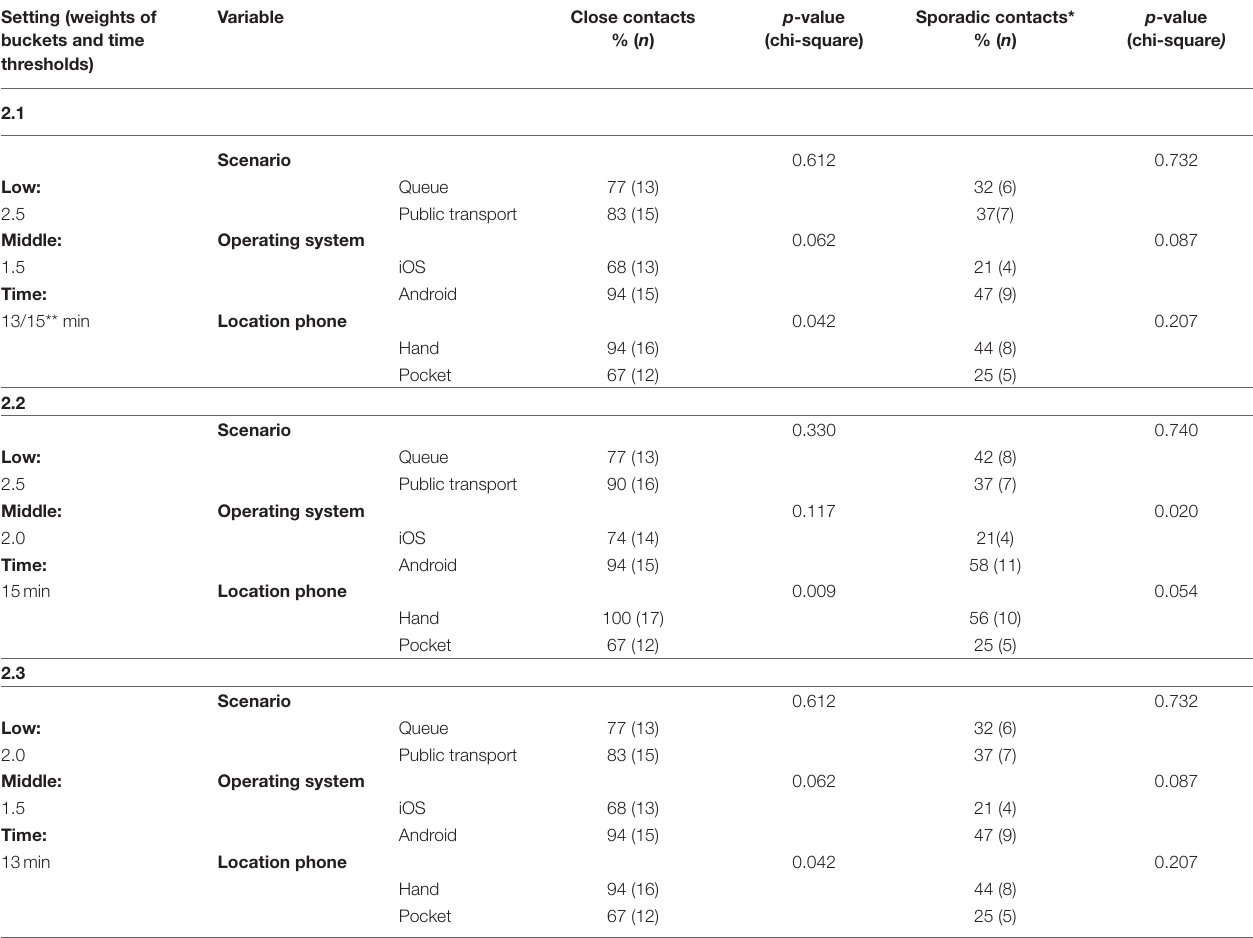
TABLE 3 | Notification rates among close contacts and sporadic contacts using configuration #2 with selected weights split by various variables. Setting (weights of buckets and time